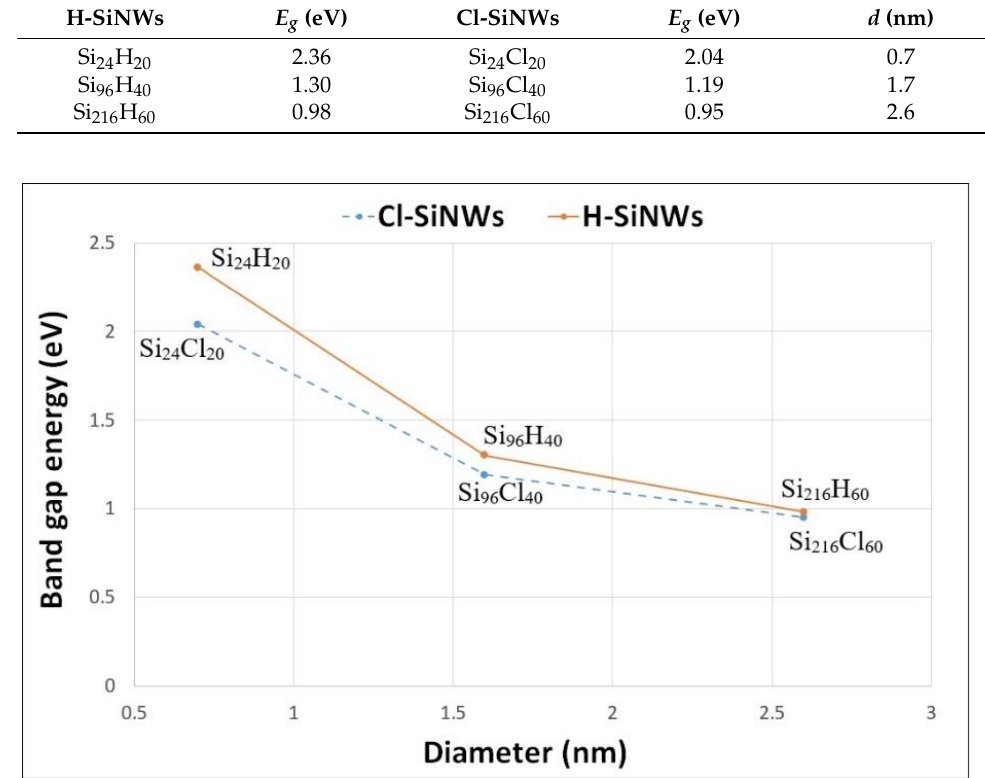
Figure 3. Computed band gap as a function of the diameter of fully passivated Cl- and H-functionalized <112> oriented SiNWs. Table 2. Energy band gap of fully passivated Cl- and H-functionalized <112> oriented SiNWs with different diameters.